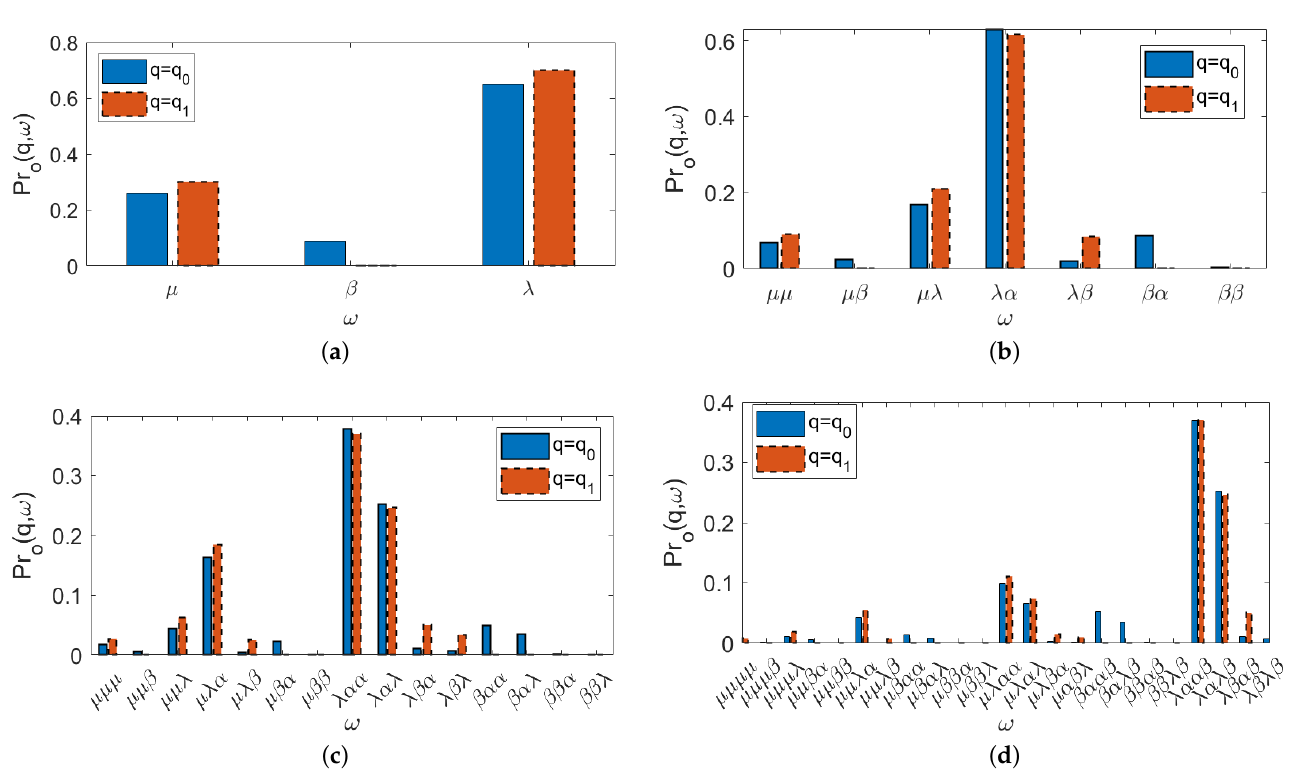
Figure 9. The probability distributions of generating observations within four-step observation